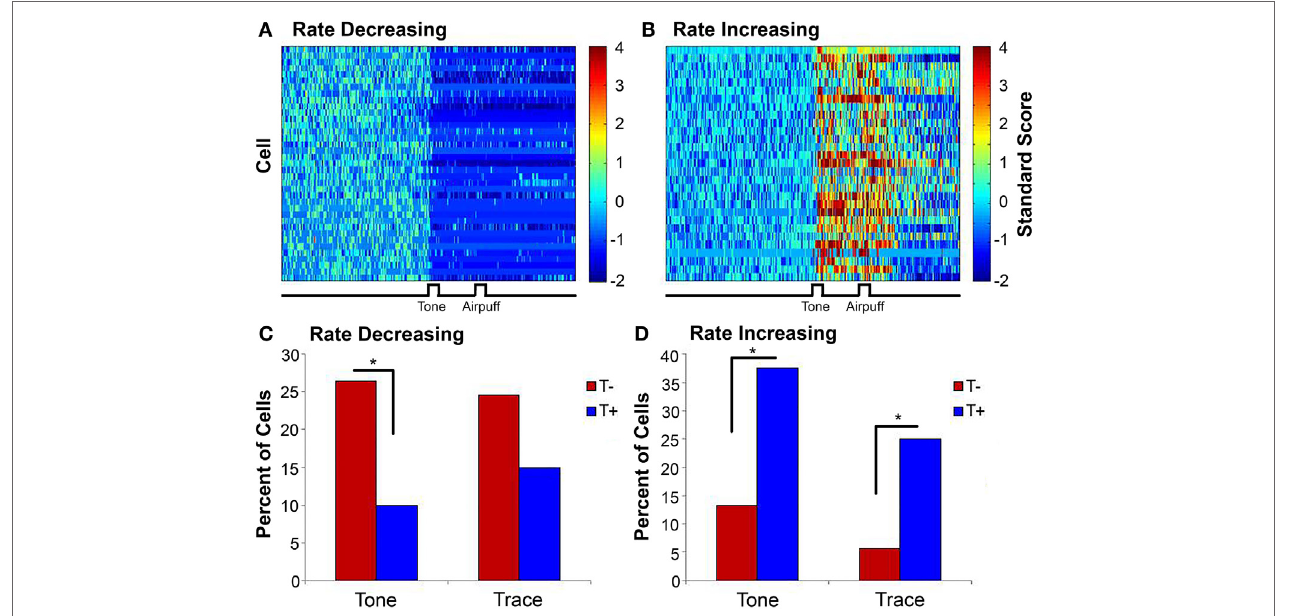
FiGURe 4 | Surface plots showing the standard scores (10-ms bins) of all rate decreasing (A) and rate increasing (B) cells averaged across the entire training session (truncated to 4 for illustration purposes) . Note that rate decreases and increases during tone presentation and are sustained past airpuff presentation. (C) A greater percentage of cells in the T − condition were rate decreasing during the tone than in the T + condition. (D) Cells in the T + condition were more likely to increase their firing during the tone and trace periods than those in T − . * p < 0.025. Figure adapted from data published in Cicchese et al.